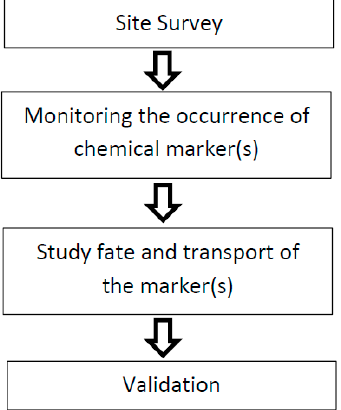
Figure 1. Approach for detecting sewer contamination using chemical markers.